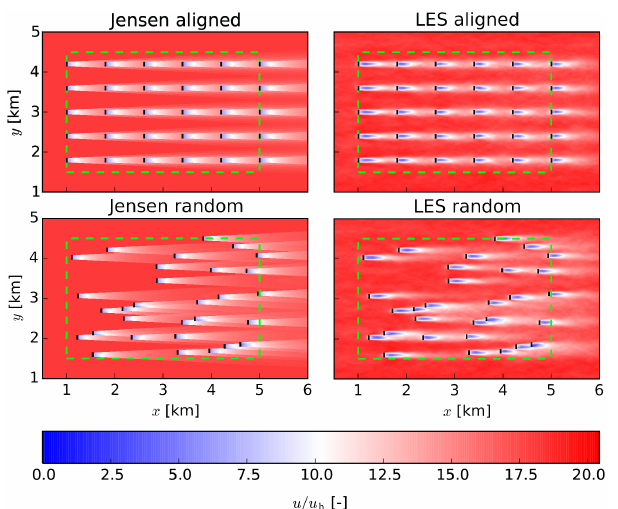
Figure 4. Comparison of Jensen model and LES for an aligned and random